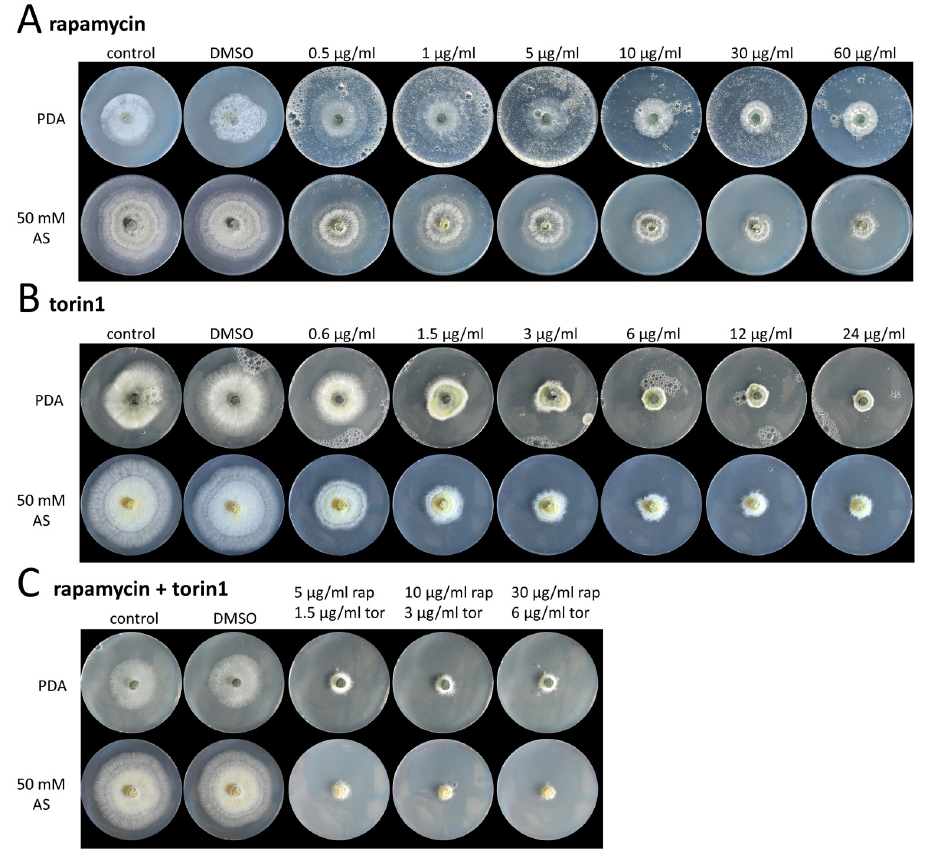
Fig 1. Radial growth of T . atroviride in the presence of TOR kinase inhibitors. The fungus was cultivated on solid potato dextrose agar (PDA) or minimal medium with 50 mM ammonium sulfate (AS) supplemented with different concentrations of (A) rapamycin, (B) torin1, and (C) different combinations of rapamycin (rap) and torin1 (tor). TOR kinase inhibitors were dissolved in DMSO and respective amounts of DMSO were used as control. Plates were incubated at 25˚C for 48 hours in the case of PDA and for 72 hours in the case of minimal medium with 50 mM AS.